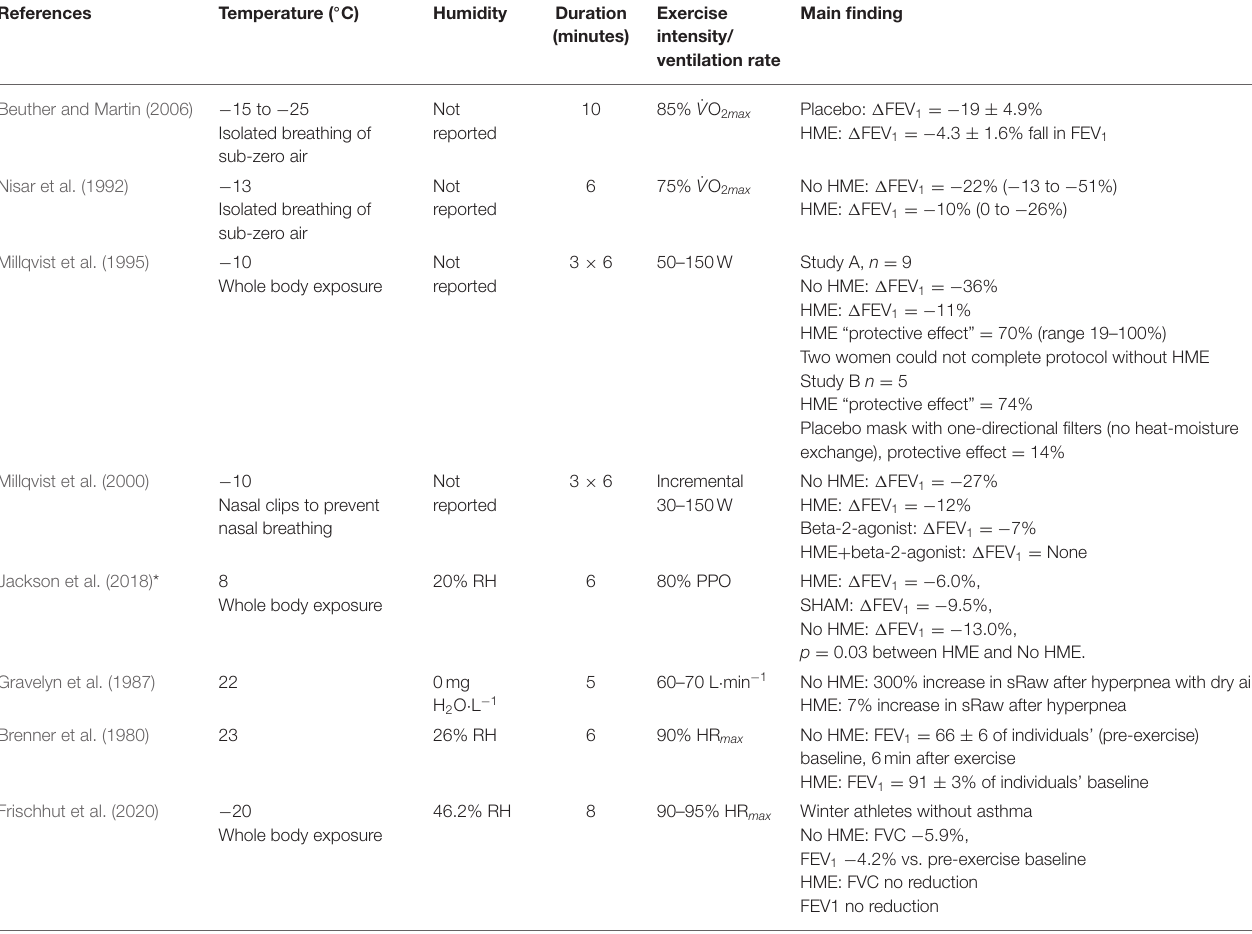
TABLE 2 | Studies showing that HMEs attenuate exercise-induced bronchoconstriction.